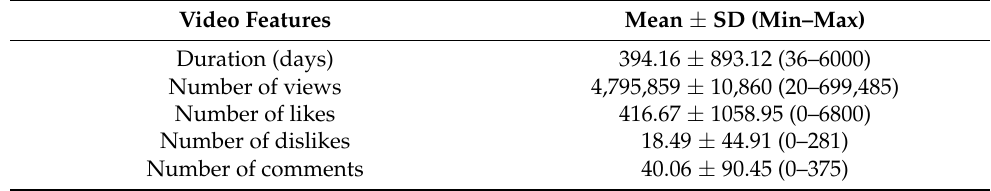
Table 1. General features of the videos. Video